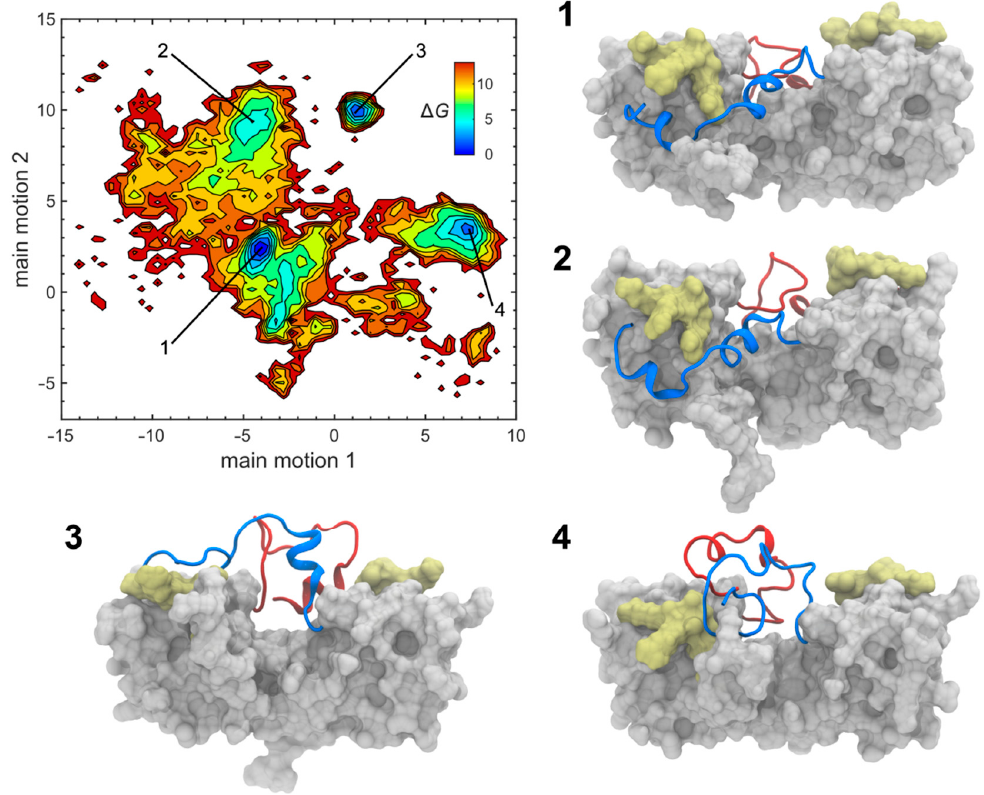
Figure 6. The free energy surface of CCL16. The free energy Δ G (given in kJ mol − 1 relative to the lowest energy state) is plotted against the two main motion vectors representing the C-terminal flexibility. Structures 1–4 correspond to the free energy minima labelled in the diagram. Conformer 1 represents the global minimum, i.e., Δ G = 0 kJ mol − 1 . Conformers 1 and 2 have their C-termini positioned laterally to the protein core, interacting with the GAG binding domain of the opposite chain. In conformers 3 and 4, the C-termini interact with each other above the groove formed between the two CCL16 chains. Residues Q1–L73 are shown as a molecular surface with the GAG binding segments (K47–R50) highlighted in yellow. C-termini (P74–Q97) are rendered as ribbons, where chains A and B are coloured blue and red, respectively. For further structural details consult Supplementary Figures S7–S10.